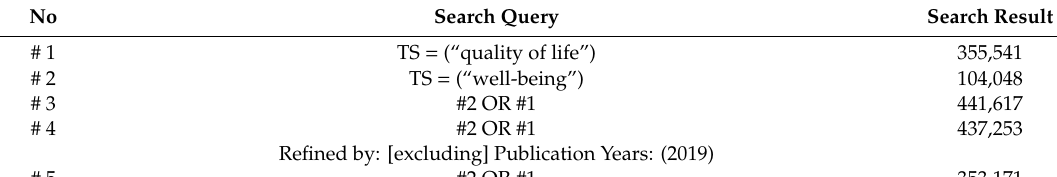
Table A1. Search query for “Quality of life” and